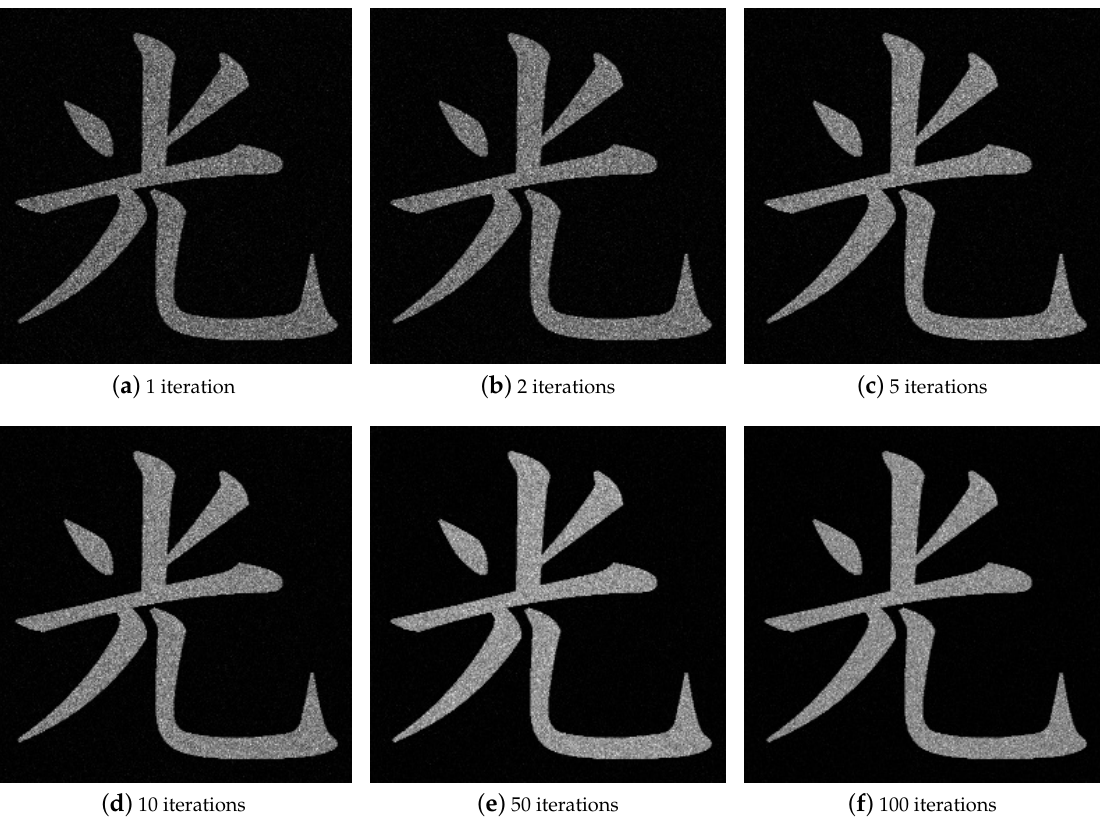
Figure 5. Reconstructed images obtained by the GS algorithm after ( a ) 1, ( b ) 2, ( c ) 5, ( d ) 10, ( e ) 50, and ( f ) 100